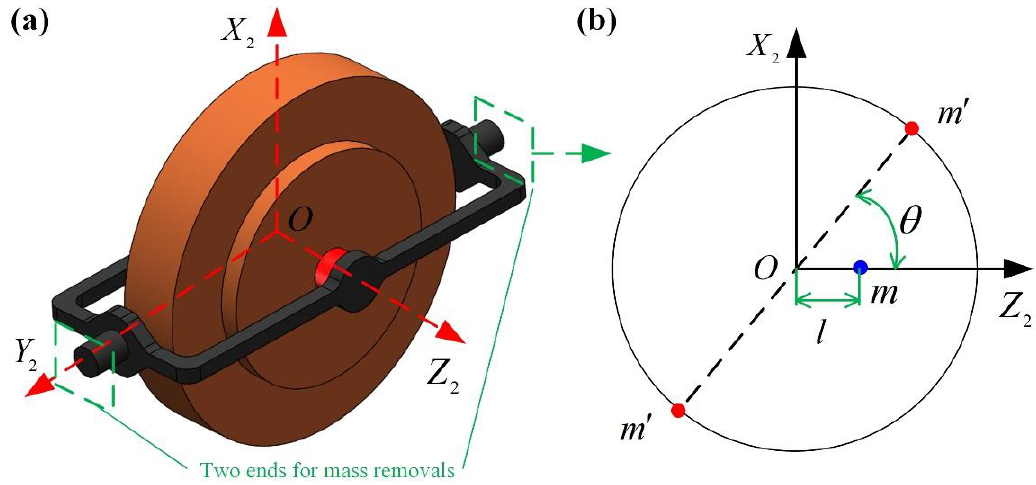
Figure 8. Illustration of the mass removal: ( a ) two ends for mass removal; ( b ) details of mass removal on each end.